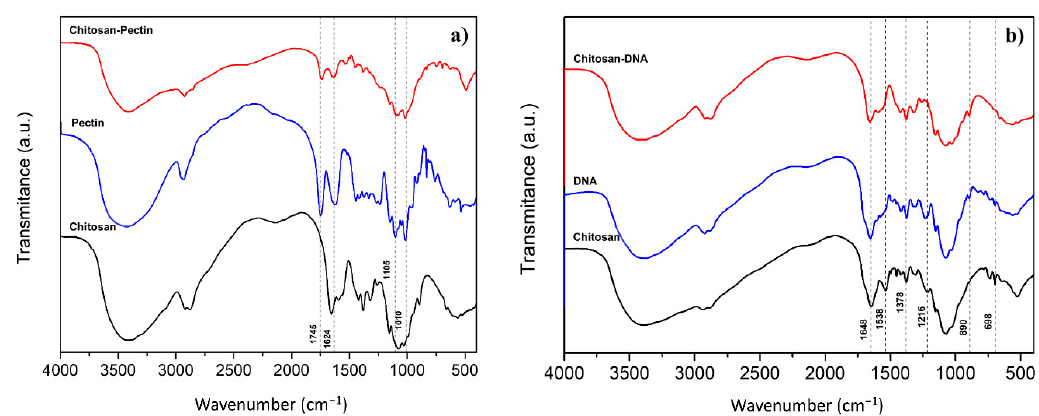
Figure 1. Infrared spectra of: ( a ) chitosan, pectin and the CS-P blend gel; and ( b ) chitosan, DNA and the CS-DNA blend gel.